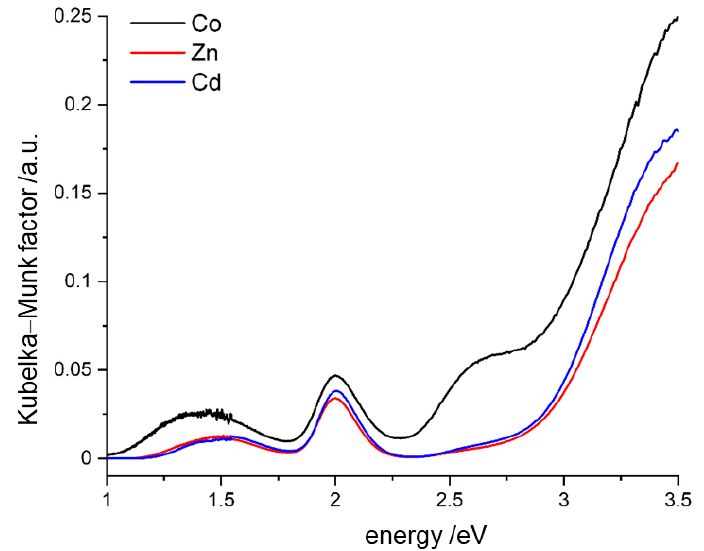
Figure 6. The UV/vis spectra of compounds